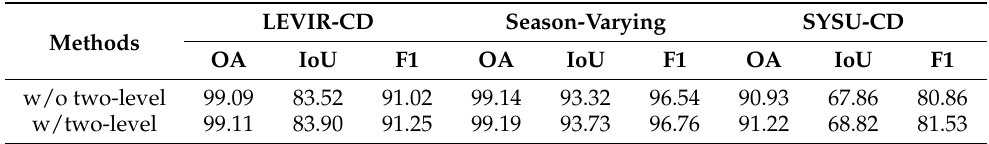
Table 5. Effects of two-level feature-fusion strategy.